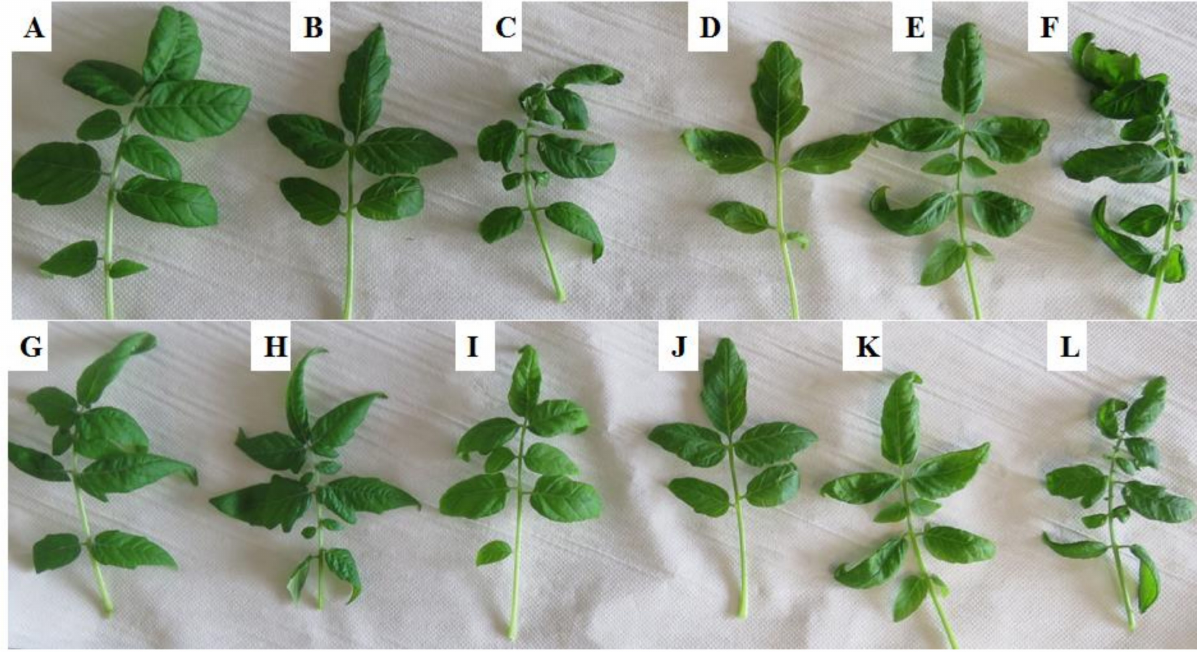
Figure 1. Symptom development in PGPR-primed tomato leaves harvested at different time points following infection with Phytophthora capsici zoospores. ( A , B ) Pseudomonas fluorescens N04 primed-unchallenged, days 2 and 8; ( C – F ) Ps. fluorescens primed-challenged—2, 4, 6 and 8 d.p.i.; ( G , H ) Paenibacillus alvei T22 primed-unchallenged, days 2 and 8; ( I – L ) Pa. alvei primed-challenged—2, 4, 6 and 8